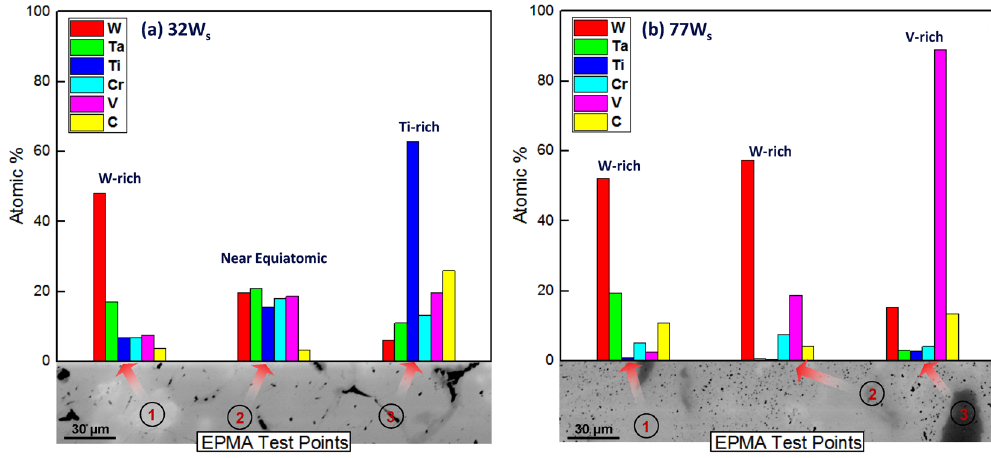
Figure 3. Various alloy compositions observed in ( a ) 32 W s and ( b ) 77 W s